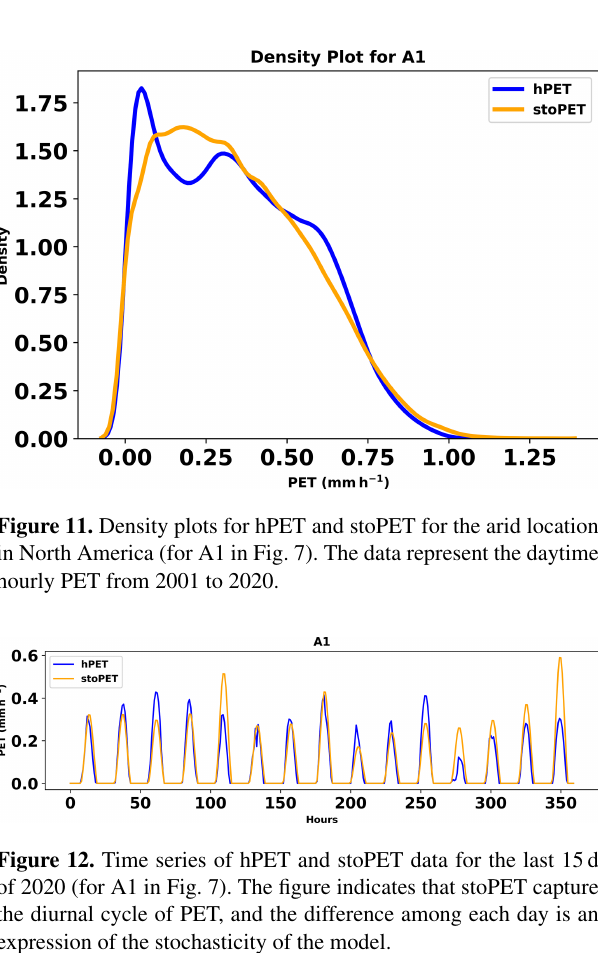
Figure 10. (a) Scatterplot between hPET and stoPET daytime values. (b) Box plots for hPET and stoPET daytime data (green triangle shows the mean and the red solid line indicates the median) over the period 2001–2020 (for A1 in Fig. 7).